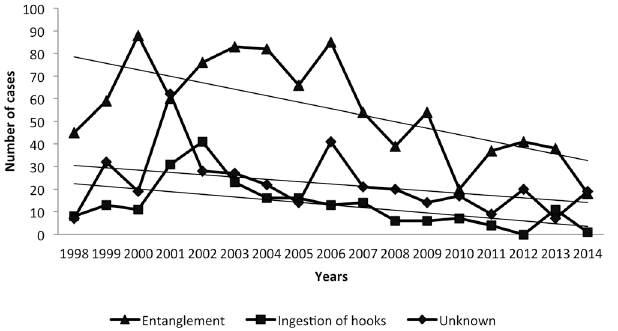
Fig 3. Tendency of the three most frequent causes of admissions during the period 1998 – 2014.